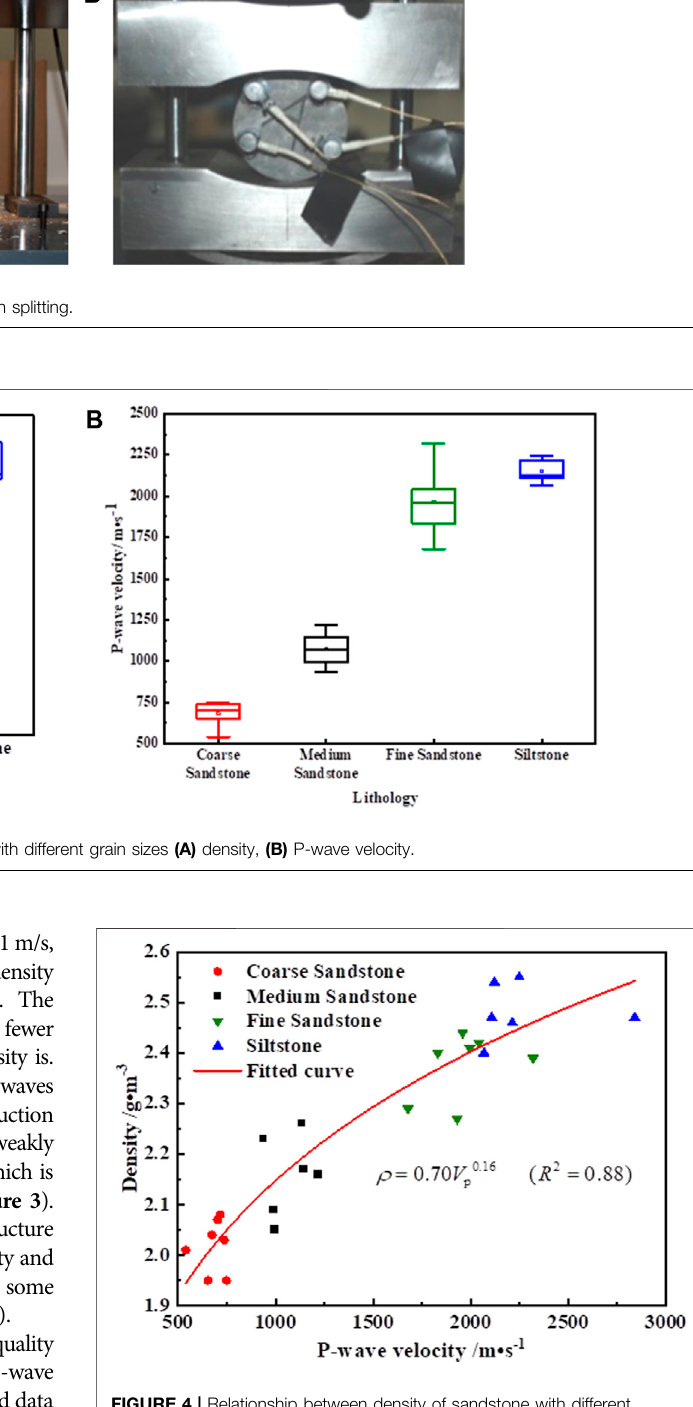
FIGURE 4 | Relationship between density of sandstone with different granularities and P-wave